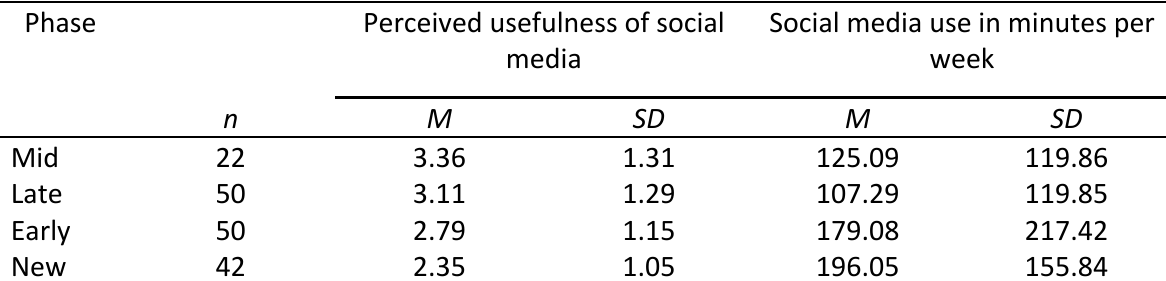
Perceived Usefulness of Social Media and Weekly Minutes of Professional Social Media Use by Teacher Career Phase